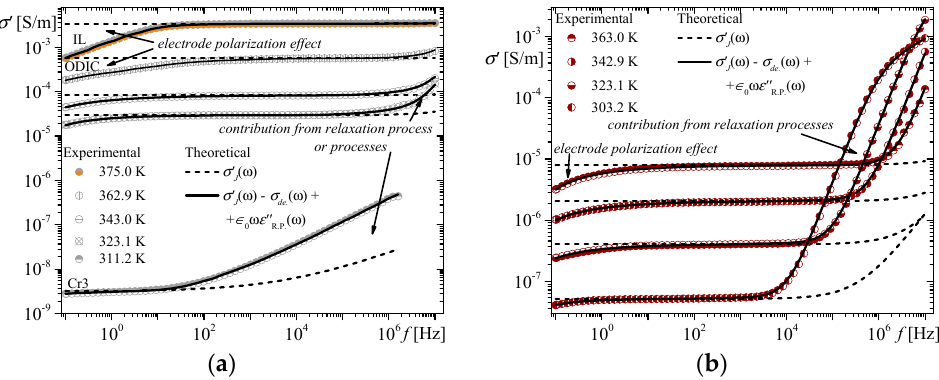
Figure 2. Real part of dielectric conductivity for ( a ) C12C in the IL phase (375.0 K), ODIC phases (362.9 K, 343.0 K, 323.1 K) and crystal Cr3 phase (311.2 K); ( b ) T13C in four temperatures of sODIC phase.